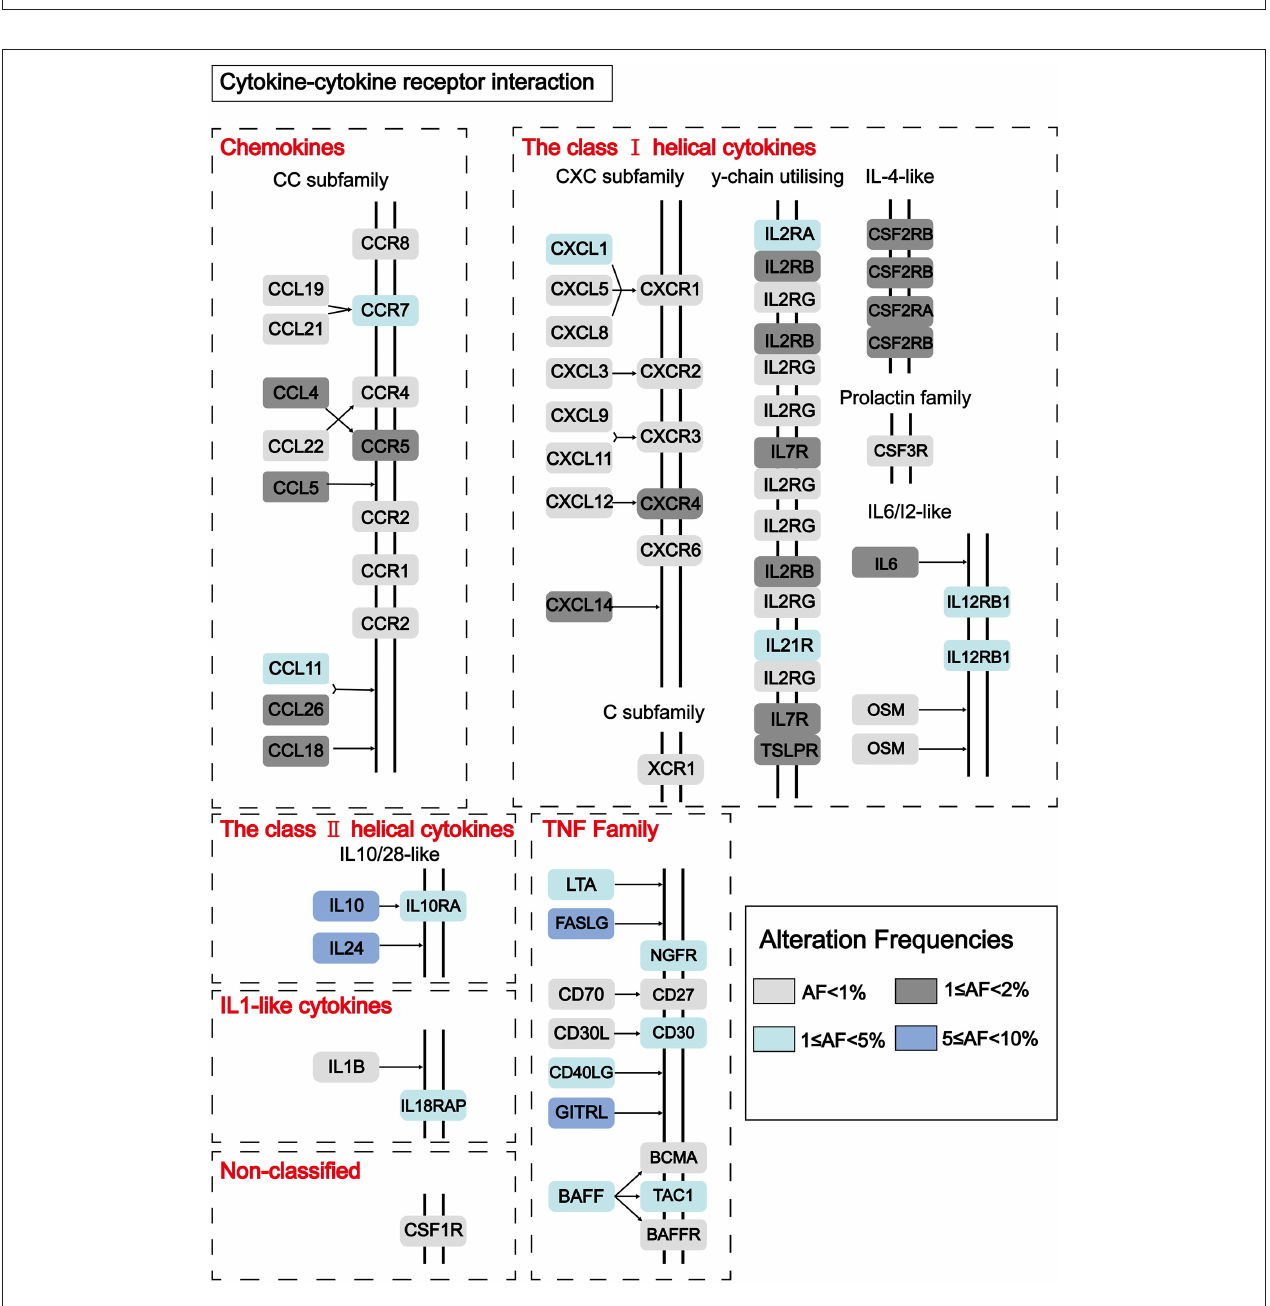
FIGURE 2 | fold change > | ± 1|). (C) 46 common downregulated genes and 850 common upregulated genes of both stromal and immune scores were shown by a Venn diagram, and a total of 896 significantly different genes were obtained. (D) The selected DEGs were used for Gene Ontology (GO)-enrichment analysis, biological process (BP), cellular component (CC), and molecular function (MF). Top 10 GO terms were displayed, respectively. (E) The selected DEGs were used for Kyoto Encyclopedia of Genes and Genomes (KEGG) enrichment analysis via Kyoto Encyclopedia of Genes and Genomes (DAVID). Considering both the p -value and count number, the optimal pathway was determined.